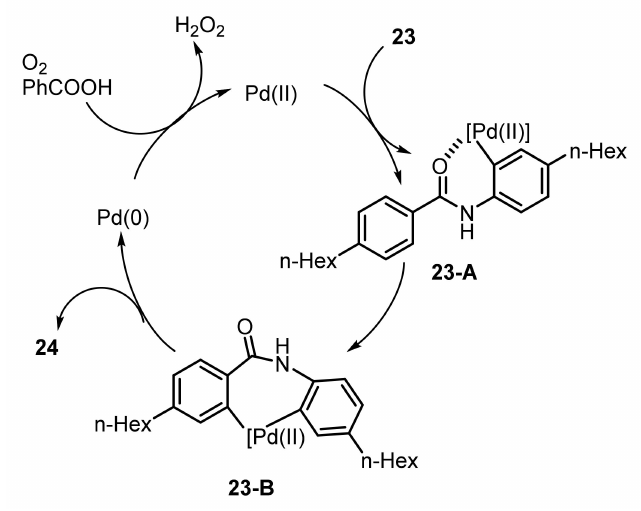
Scheme 14. Proposed mechanism for the biaryl dehydrogenative